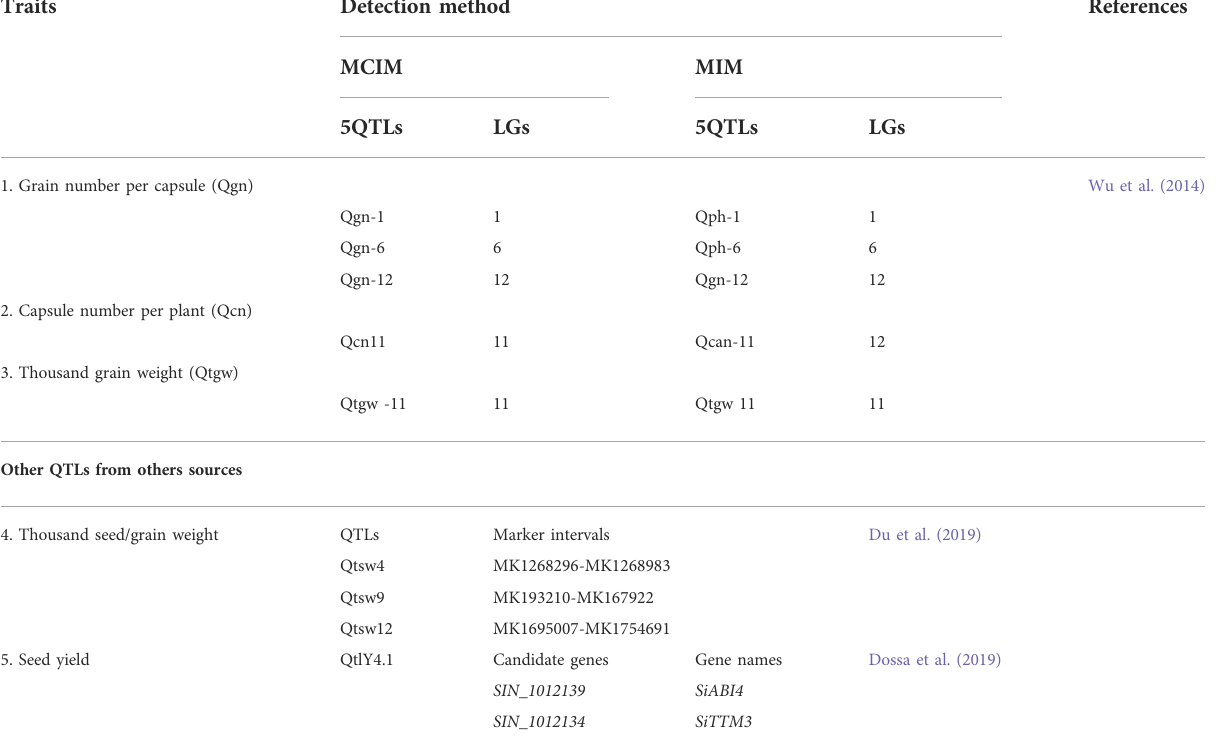
TABLE 5 QTLs for sesame grain/seed yield and yield-related traits. Traits Detection